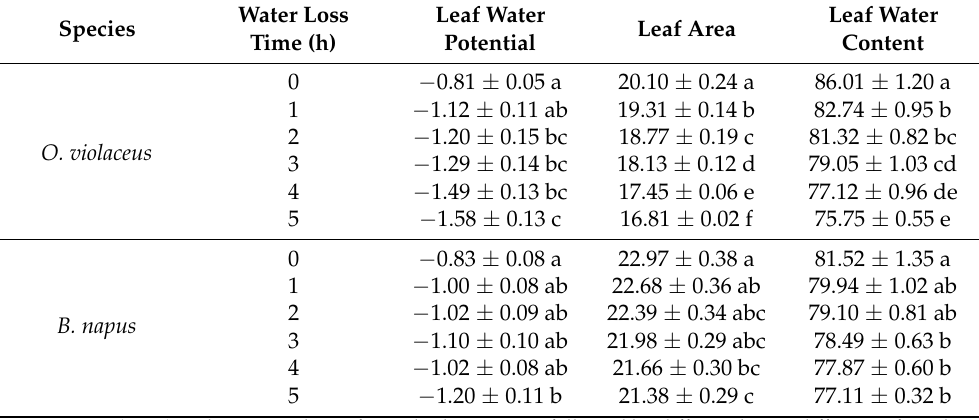
Table 1. Leaf water potential ( Ψ L , MPa), leaf area (LA, cm 2 ) and leaf water content (WC, %) at different dehydration times. Water Loss Leaf Water Species Leaf Time (h) Potential